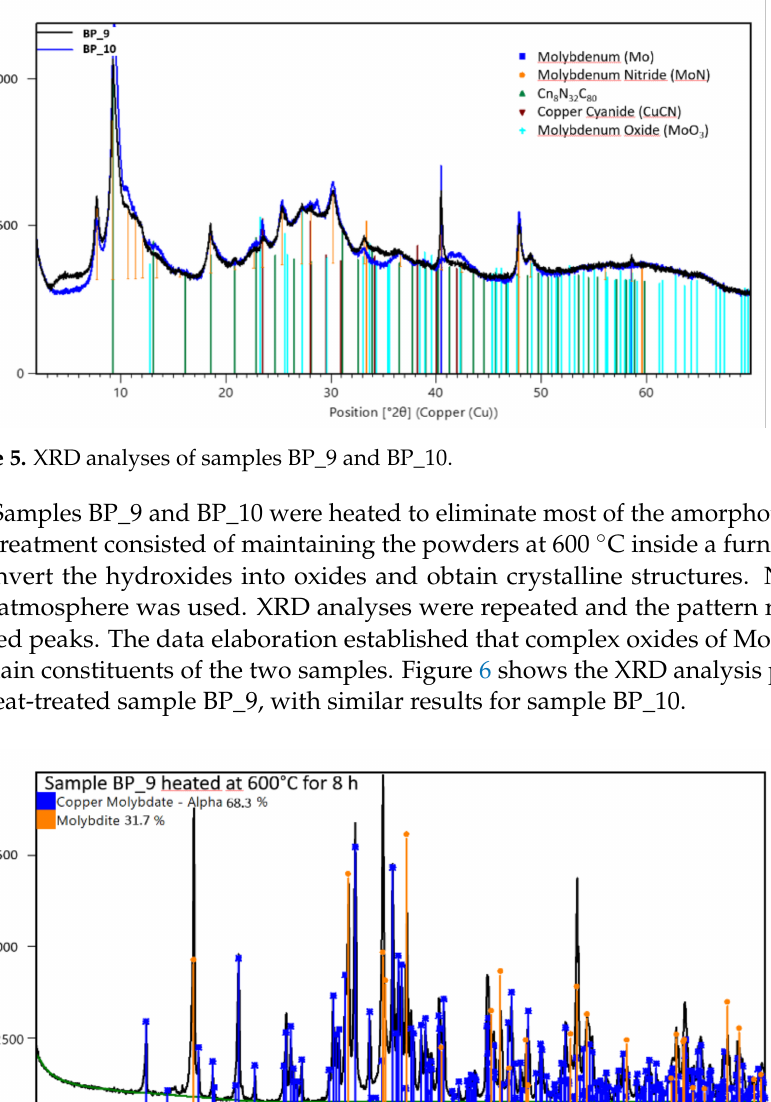
Table 2. Chemical composition percentage.